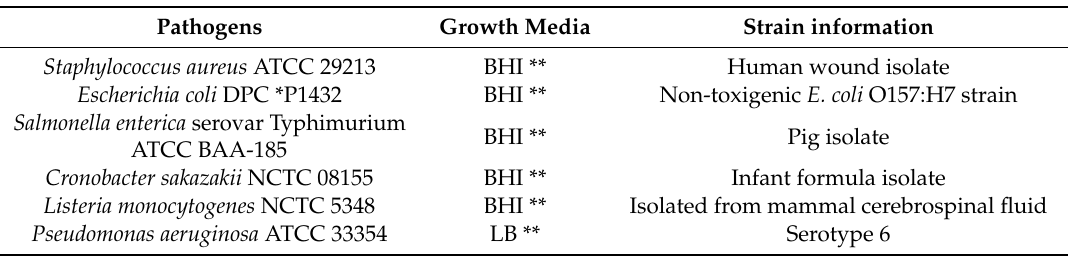
Table 1. List of bacterial